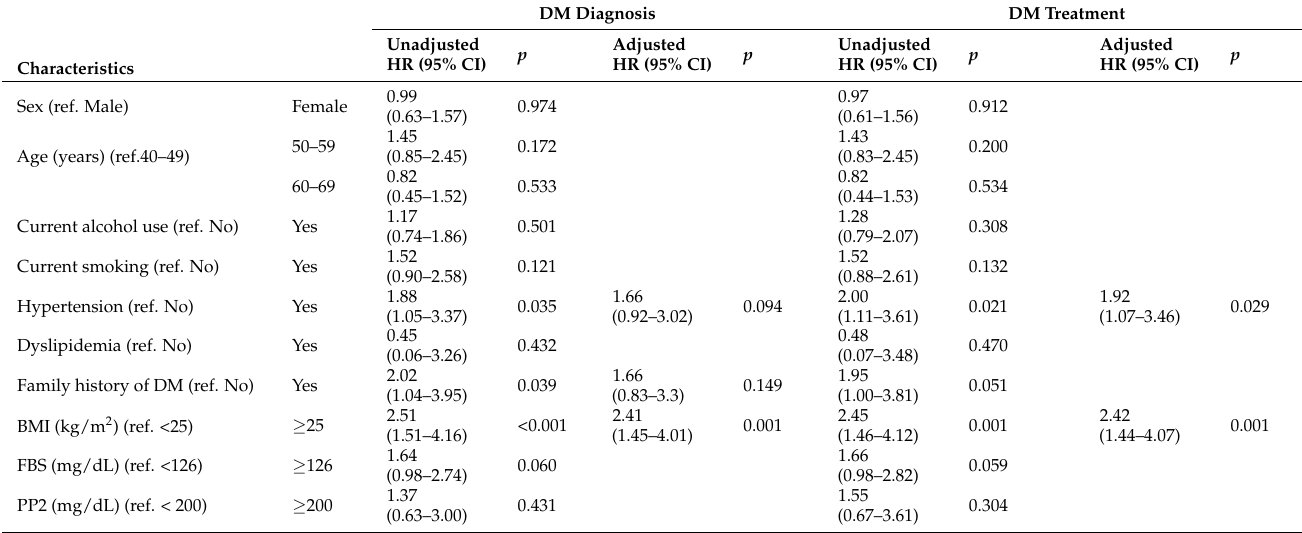
Table 4. Risk factors for DM diagnosis and treatment (N = 186).